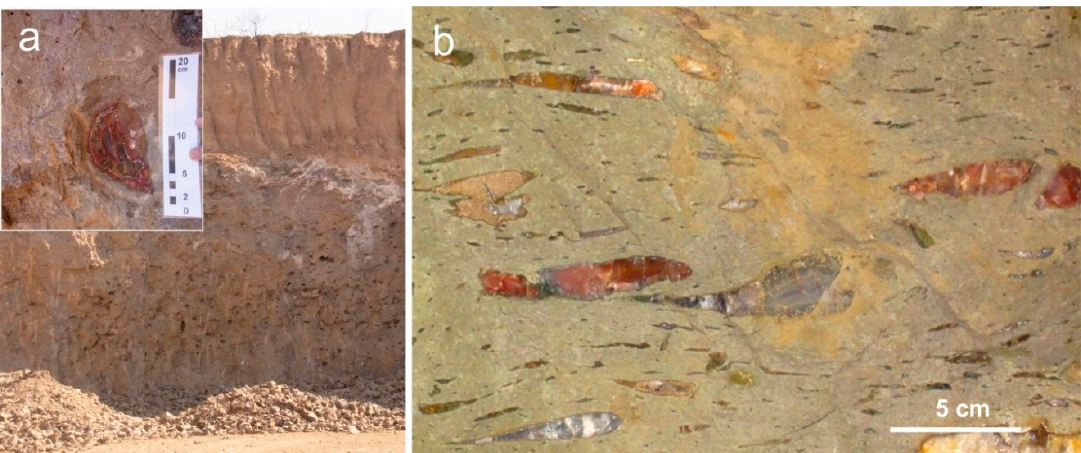
Figure 24. ( a ) Vesicular trachyandesite in the agate quarry of Dishuya (Hebei province, China); the numerous cavities formed by fluid bubbles that got stuck in the cooling lava; the inset shows an agate ‐ filled cavity (amygdale); ( b ) agate ‐ filled former bubbles arranged in the flow texture of the solidified andesitic lava from the Steinkaulenberg, Idar ‐ Oberstein (Germany).